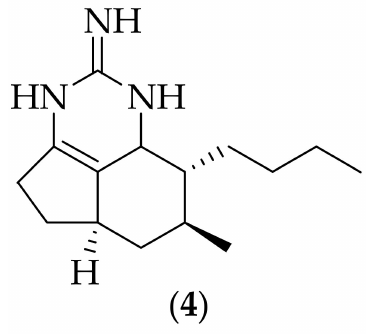
Figure 2. Structure of mirabilin B ( 4 ).